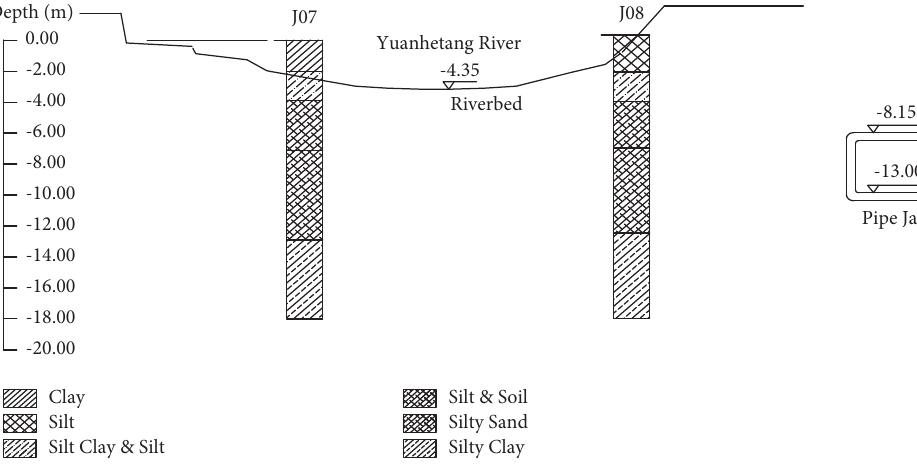
Figure 2: Soil layer information and pipe jacking spatial location